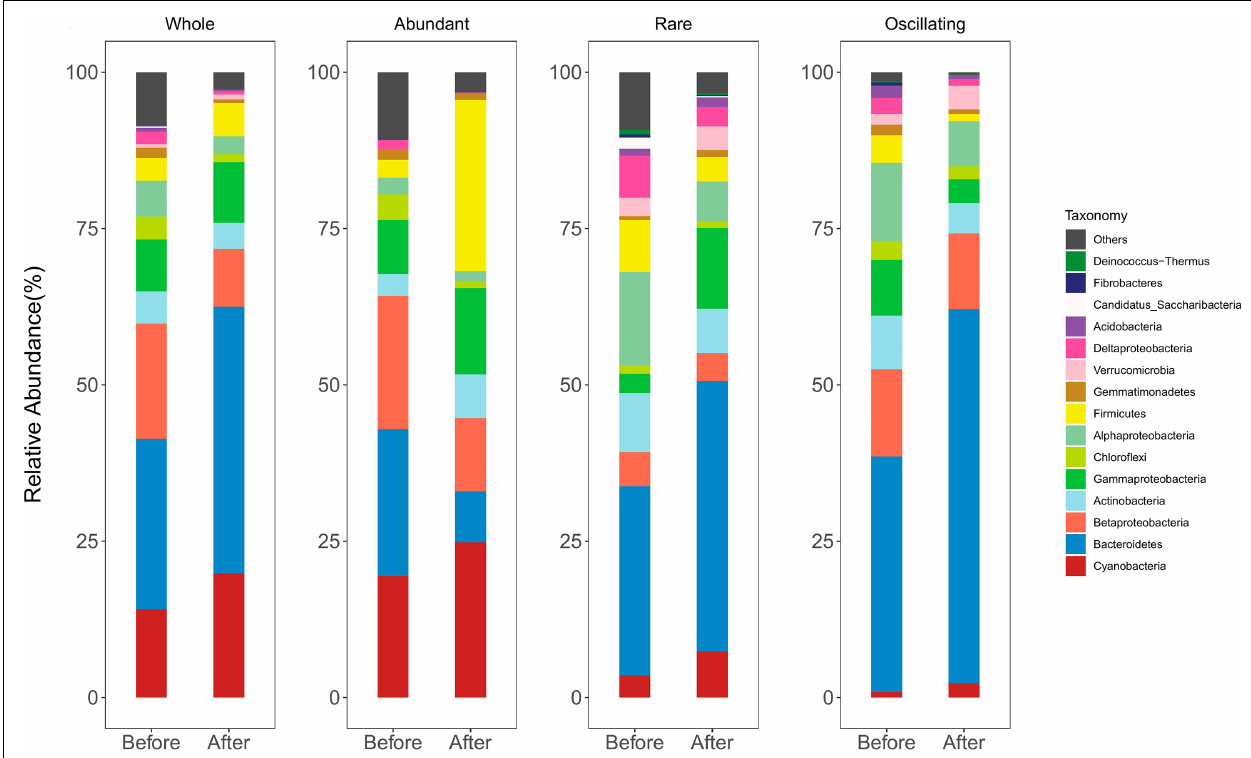
FIGURE 2 | Taxonomic composition of bacteria before and after snowfalls in whole, abundant, and rare communities. The communities were dominated by Cyanobacteria, Bacteroidetes, Betaproteobacteria, Actinobacteria, Gammaproteobacteria, Chloroflexi, Alphaproteobacteria, and Firmicutes.